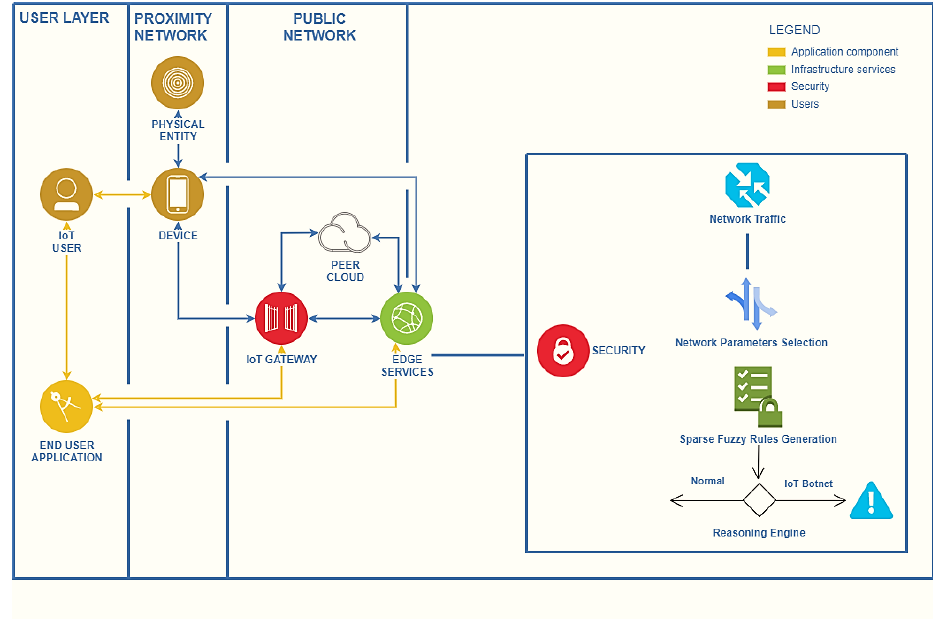
Figure 1. The General Architecture of the Suggested Detection